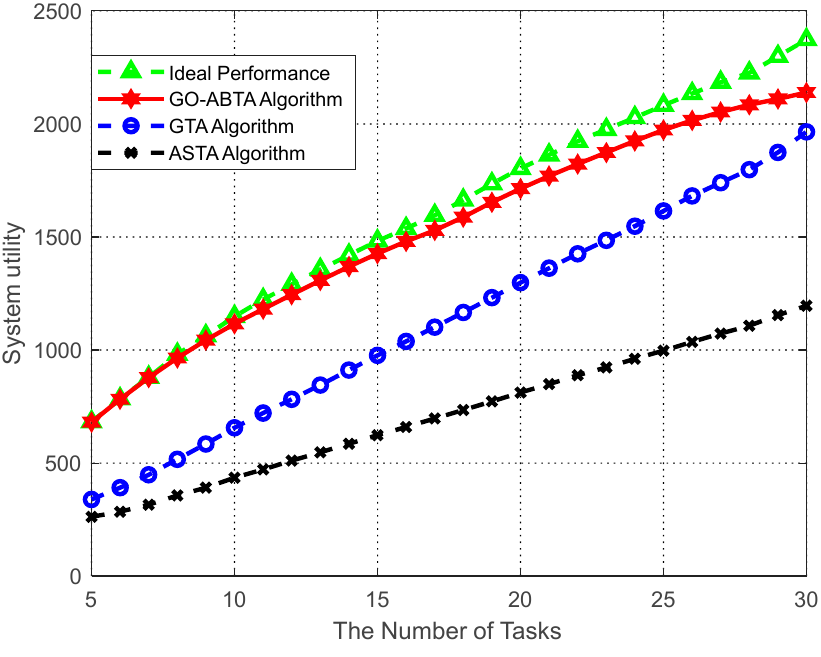
Figure 5. Performance comparison of system utility versus number of tasks.